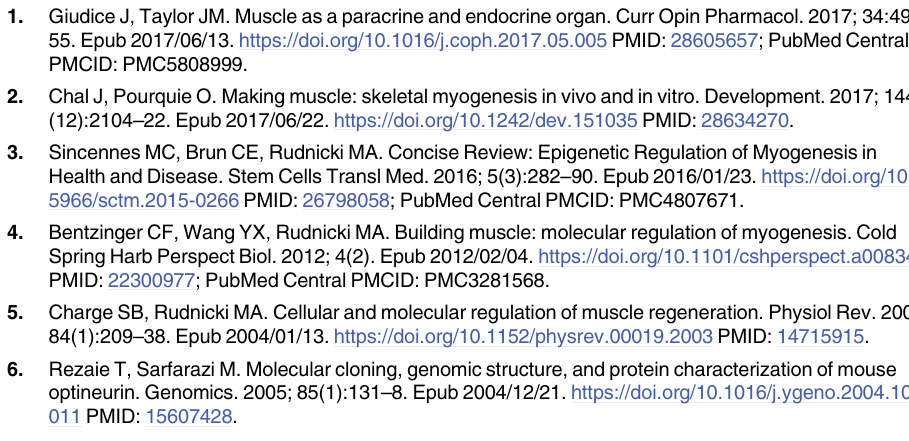
S1 Raw Image. Original blot contains Figs 1B, 1H, 2A, 2F, 2L, 3E, 3F, 4A, 4B, 4C, 4D,